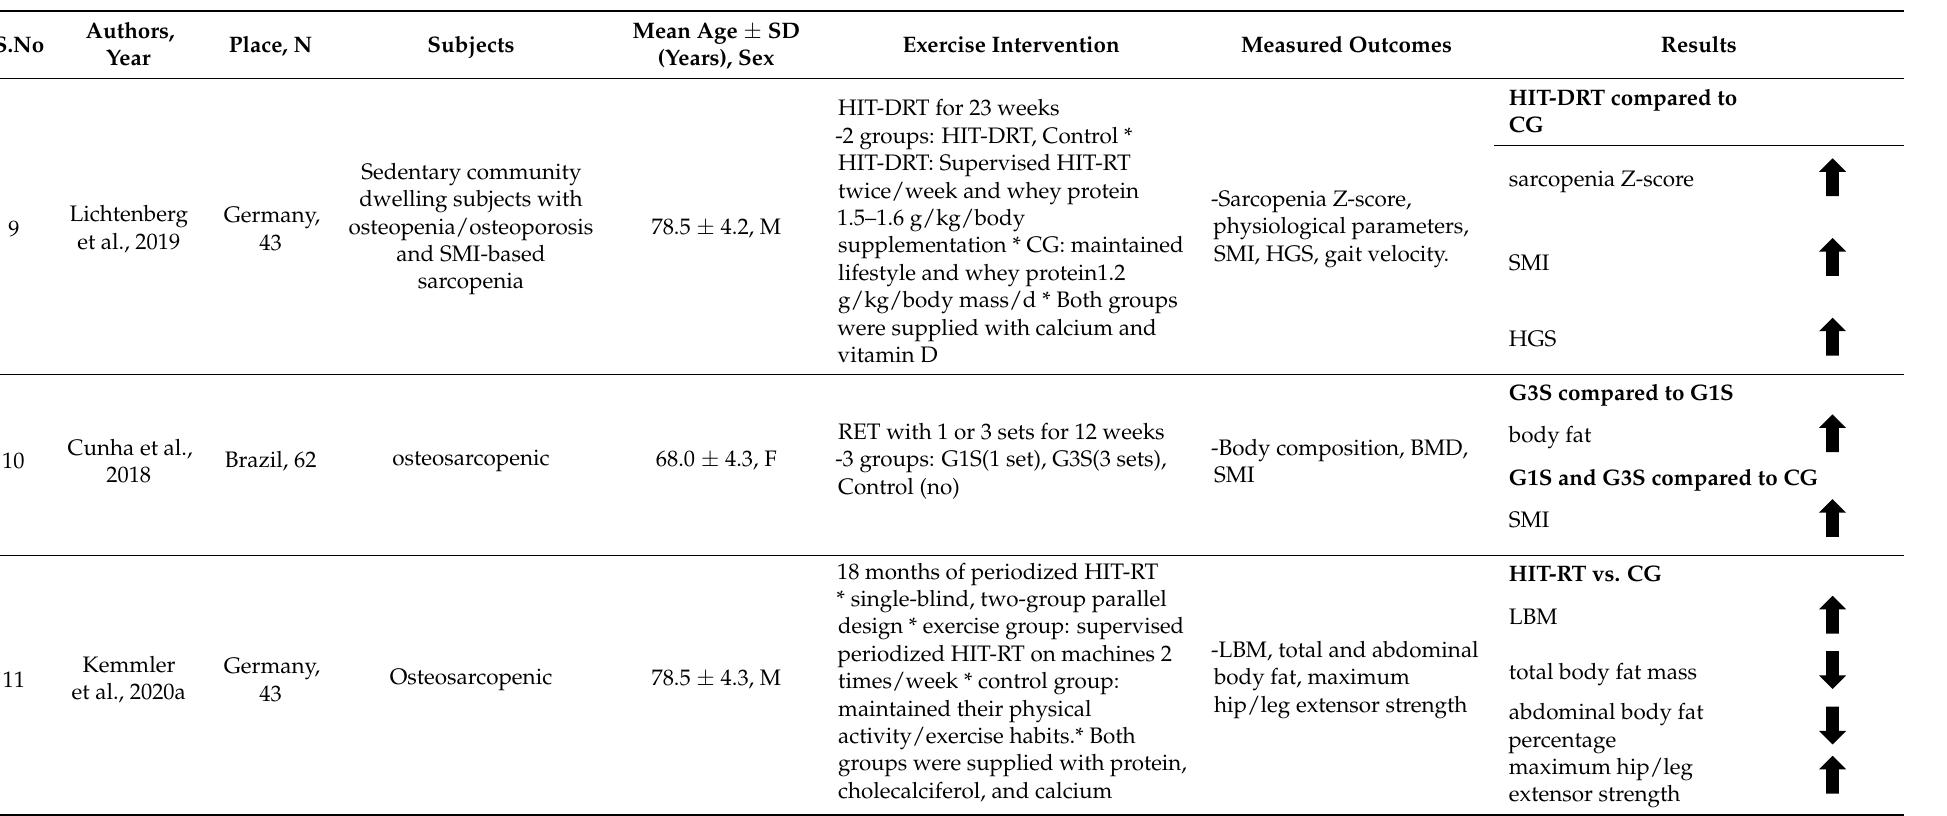
Table 1. Effect of exercise on subjects with cancer and baseline measurement of sarcopenia. Table 2. Cont.